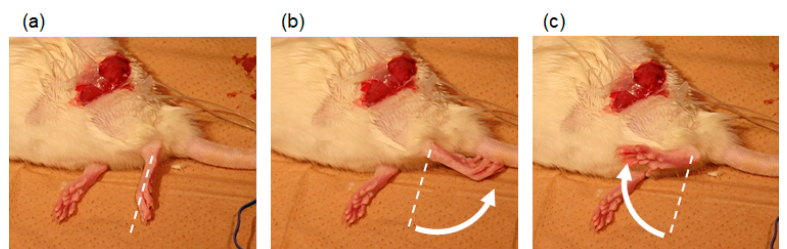
Figure 9. Selective stimulation of rat peroneal and tibial nerves ( a ) Without stimulation; ( b ) With stimulation to the tibial nerve to generate plantar flexion of the ankle joint; ( c ) With stimulation to the peroneal nerve to generate dorsal flexion of the ankle joint.